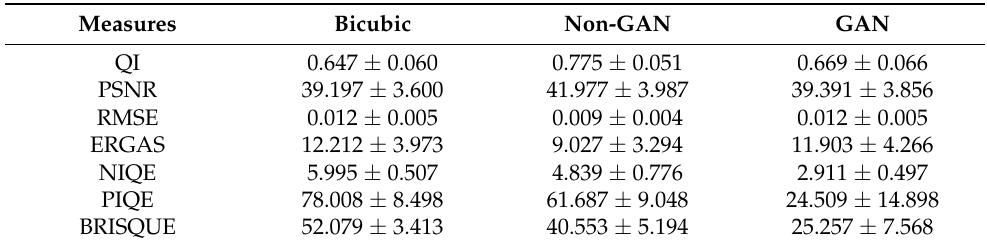
Table 3. Model performance in the simulated data experiment assessed by full-reference and non- reference